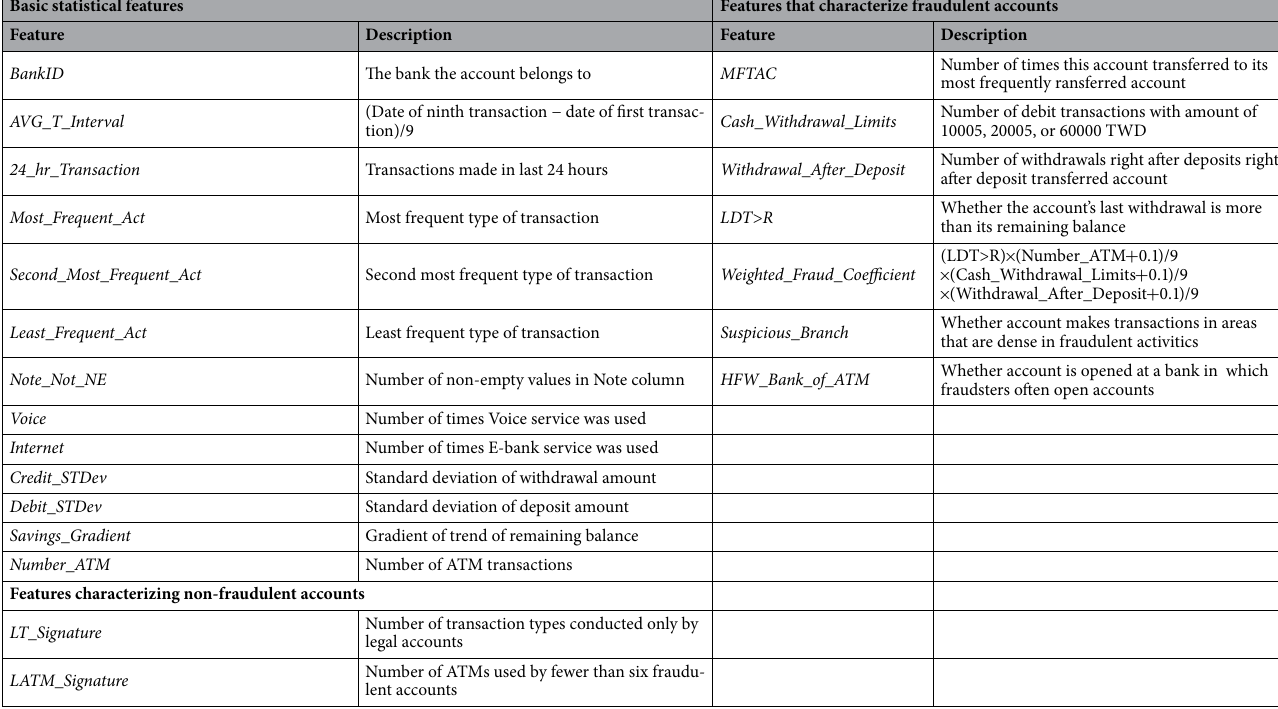
Table 1. Basic statistical features of nine most recent transactions for each